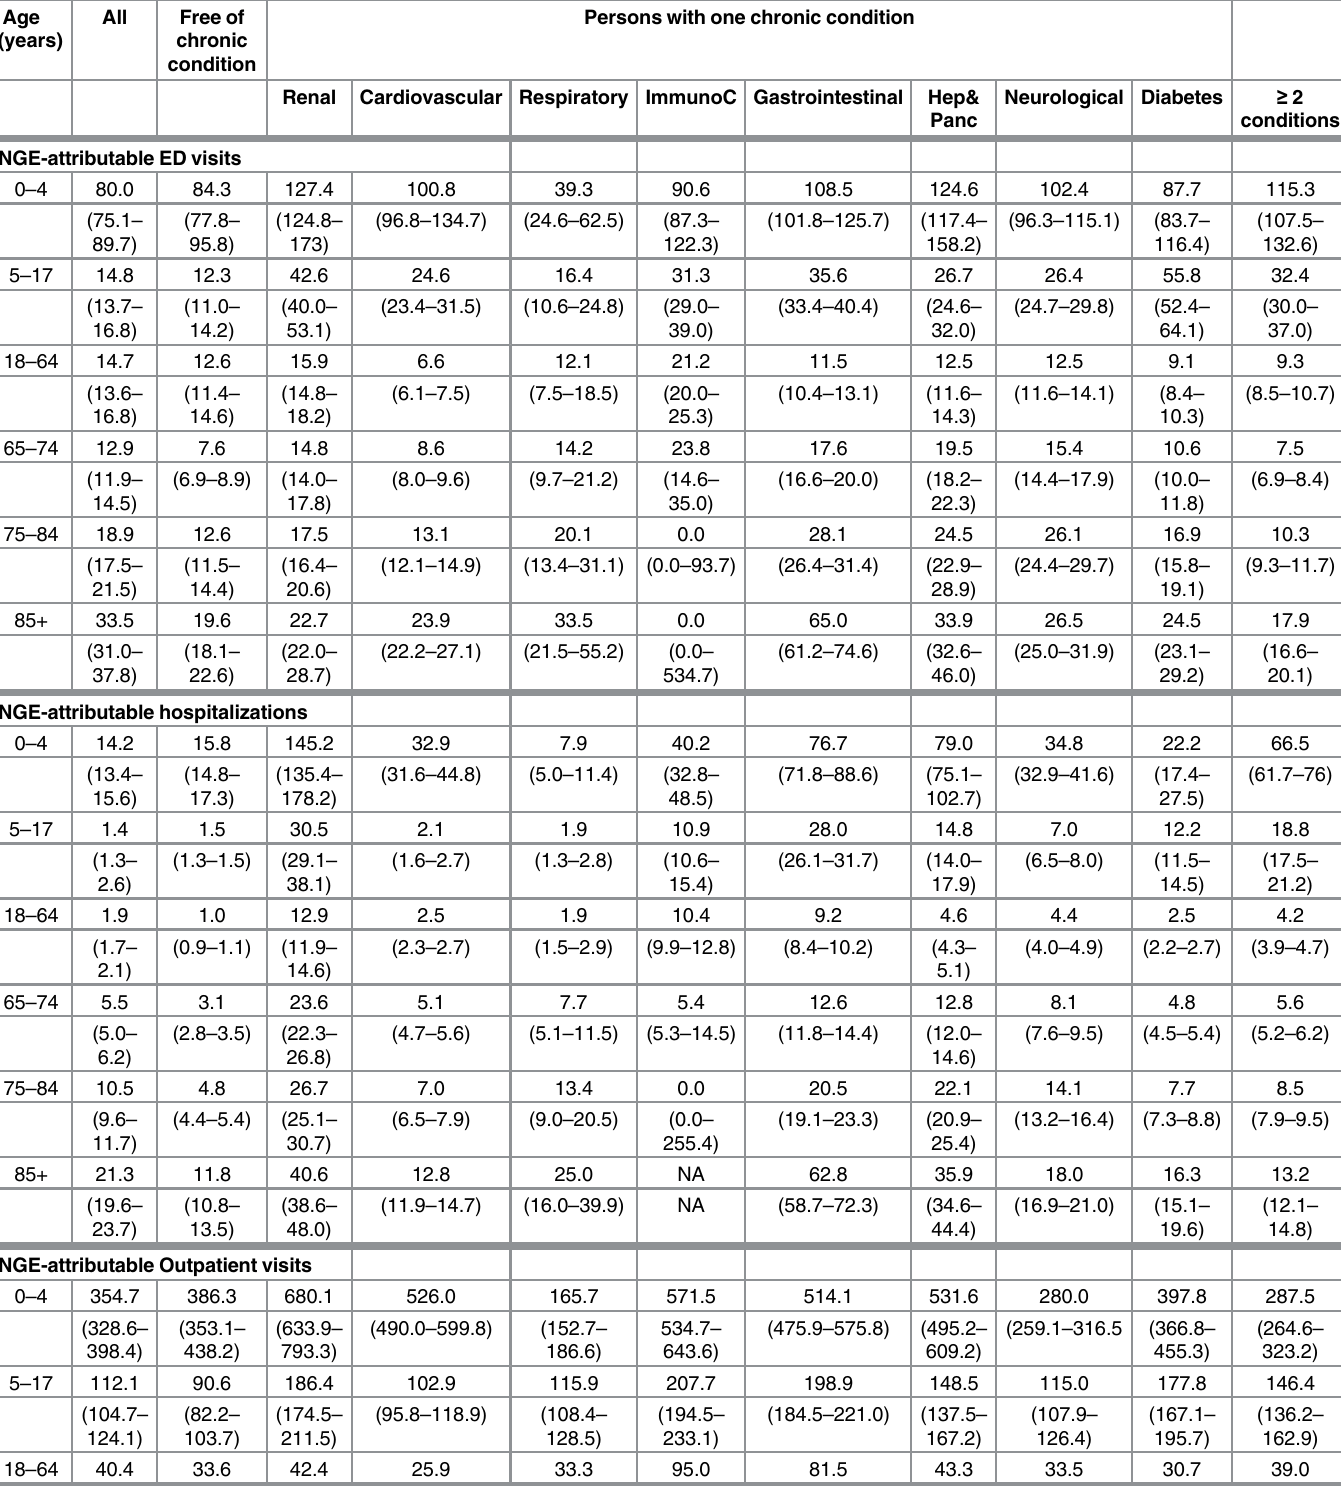
Table 5. Mean annual rate (per 10,000 person-years with 95% confidence intervals) of norovirus gastroenteritis (NGE)-attributable emergency department (ED) visits, hospitalizations and outpatient visits by age (2002 – 2013 MarketScan